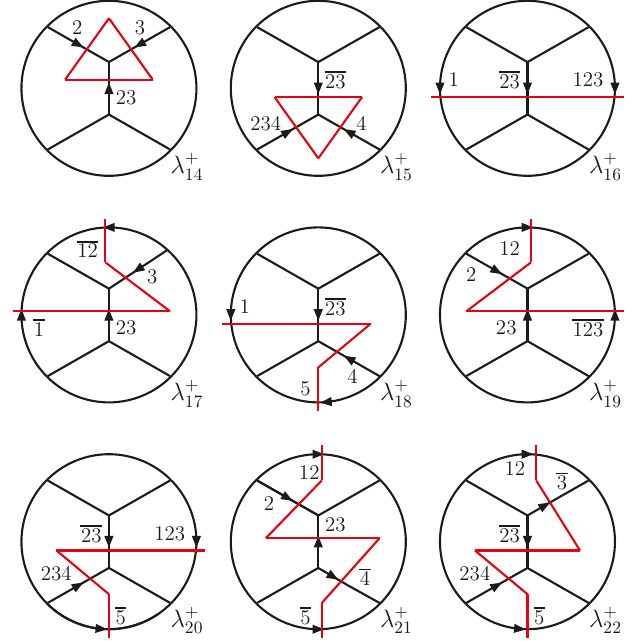
Figure 8 . Extra causal configurations of the t -channel of the N 4 MLT